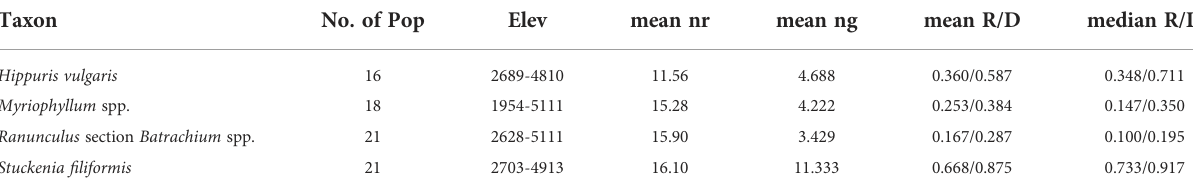
TABLE 1 Information on the number and elevation range of sampled populations, average number of ramets and genets and clonal diversity for relative taxon. Taxon No. of Pop Elev